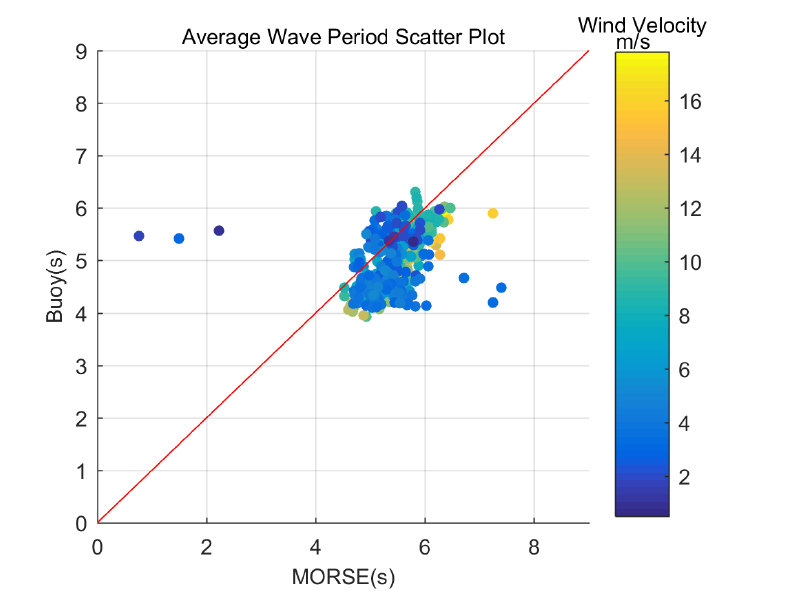
Figure 15. Scatter plot of average wave period measured by MORSE and the